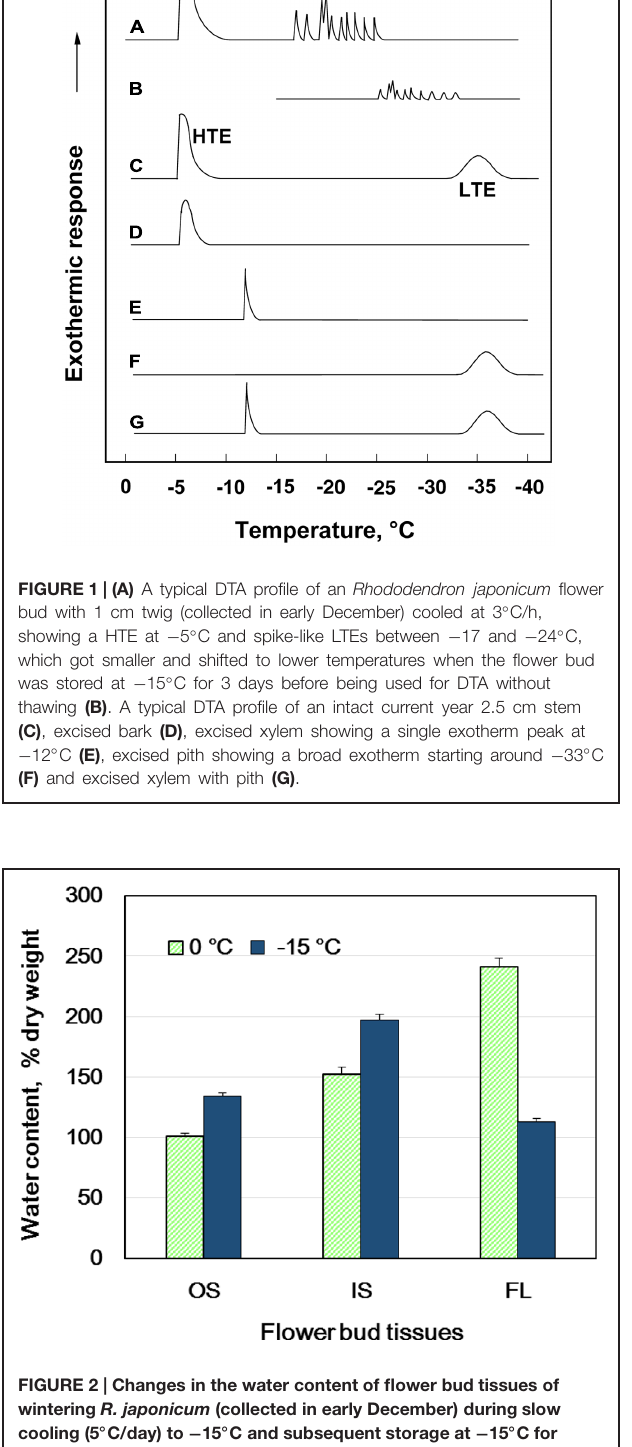
Frontiers in Plant Science |